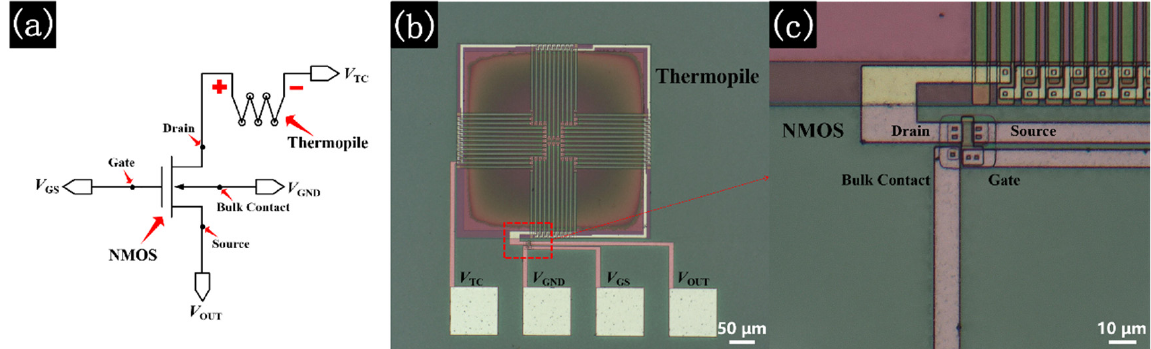
Figure 1. ( a ) Equivalent model of TISA pixel, ( b ) optical image of TISA pixel, ( c ) an enlarged image of NMOS .